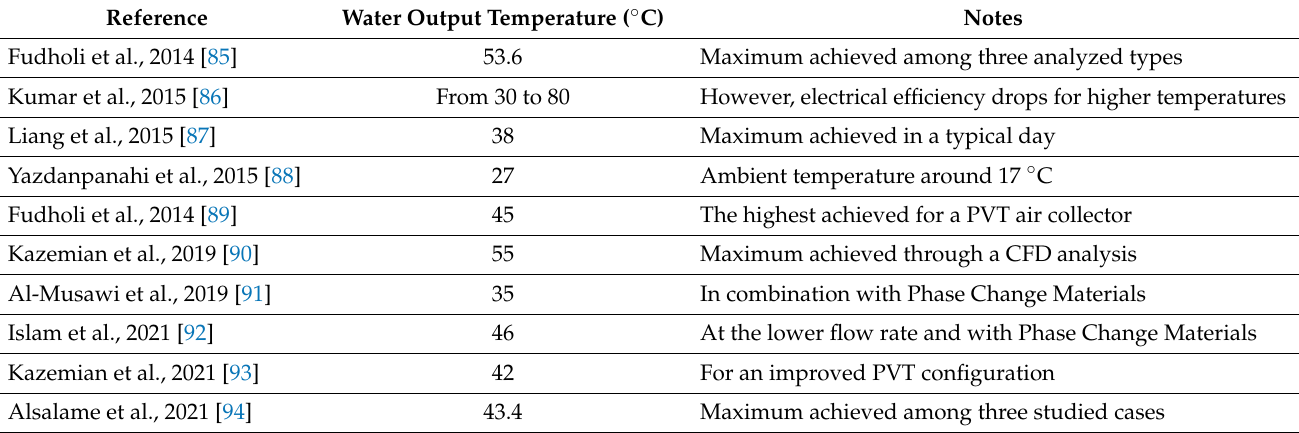
Table 7. Literature review of the values for PVT selected parameter.